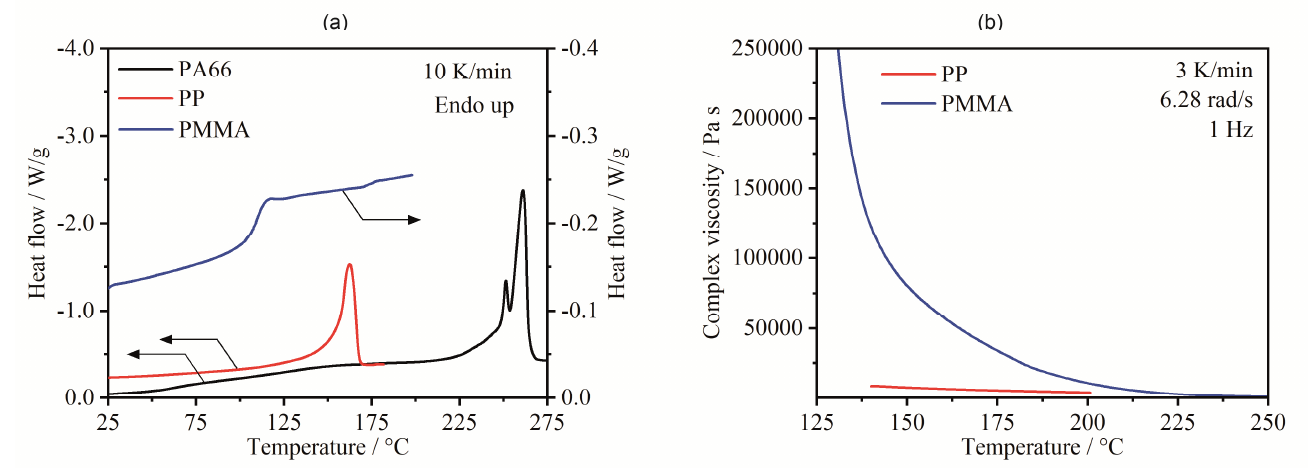
Figure 5. Thermal characterization of the base materials: ( a ) melting behavior, ( b ) rheological behavior.